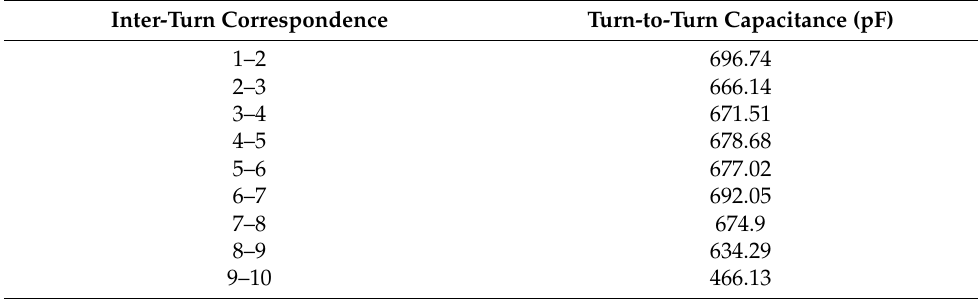
Figure 6. Transformer high-voltage winding model. Table 3. Capacitance matrix of top first-wire pie calculated by the finite element